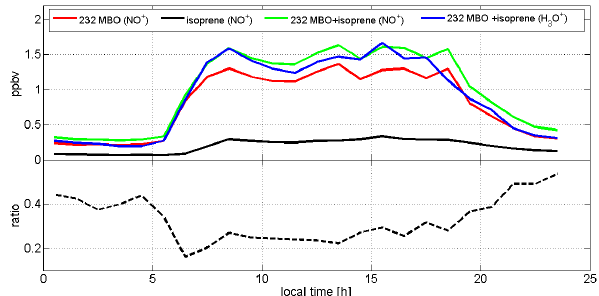
Fig. 6. Diurnal concentrations of isoprene and 232MBO using two PTR-TOF-MS instruments (upper panel); one instrument was oper- ated in H 3 O + mode depicting 232MBO + isoprene (blue trace); the other instrument was operated in NO + mode separating 232MBO (red) and isoprene (black). The sum of the two is also plotted for comparison (green trace). The lower panel depicts the ratio between isoprene and